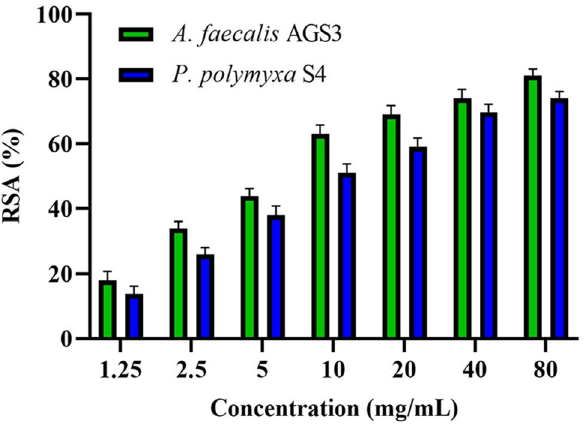
Figure 4. Assessment of antioxidant properties of oligosaccharides obtained from pectin degradation by DPPH